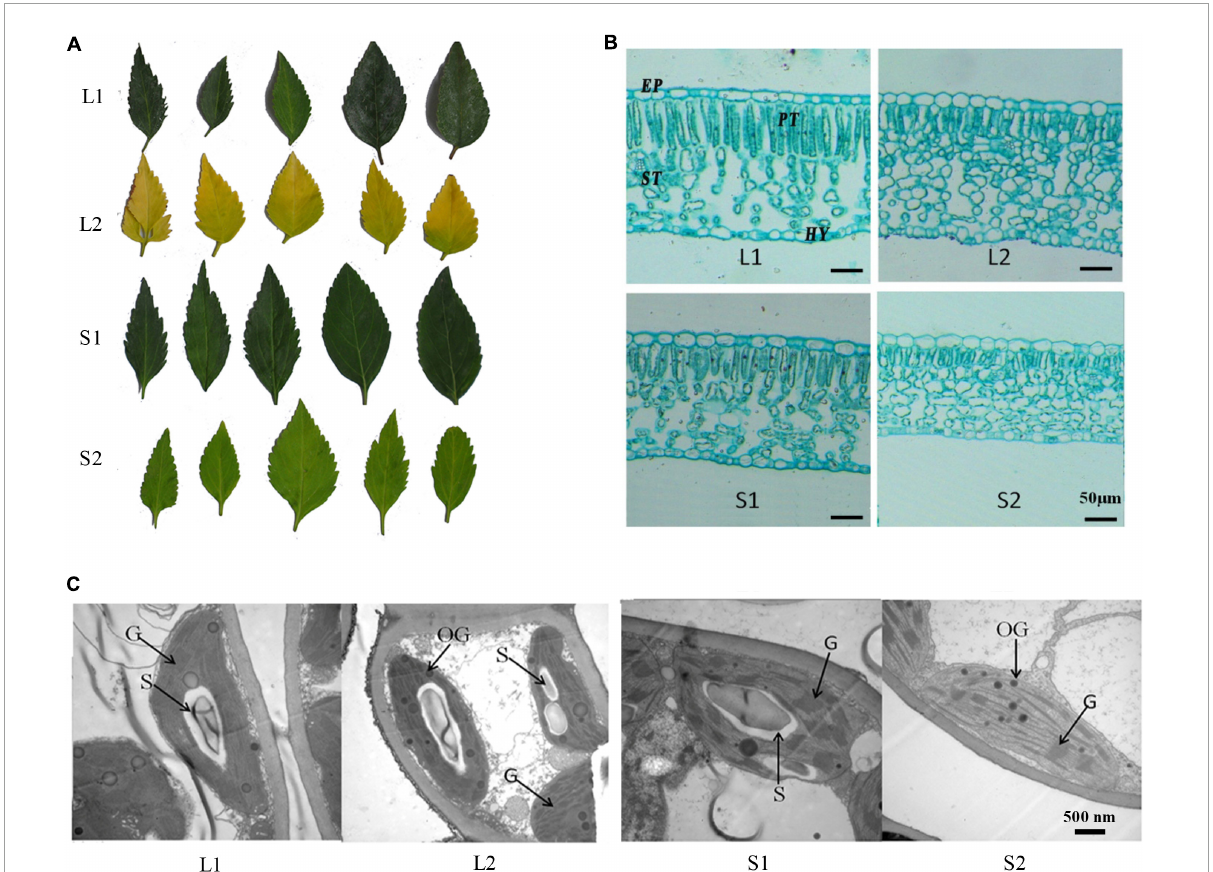
FIGURE1 Phenotypic analysis of yellow-leaf and green-leaf Forsythia plants under different light-intensity treatments. (A) Leaf color of four groups (L1: green-leaf Forsythia under natural light condition; L2: yellow-leaf Forsythia under natural light condition; S1: green-leaf Forsythia under shade condition; S2: yellow-leaf Forsythia under shade condition). (B) Leaf anatomy of plants in four groups. EP refers to epidermis; PT refers to palisade tissue; ST refers to spongy tissue; HY refers to Hypodermis. (C) Chloroplast ultrastructure of plants in four groups. G refers to granum; S refers to starch grain; OG refers to osmiophilic globule.